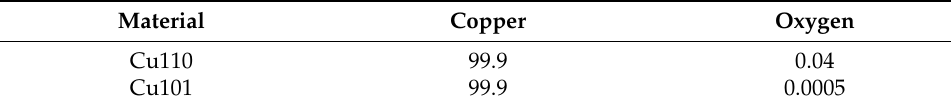
Table 2. Chemical composition of copper alloys, % by weight.